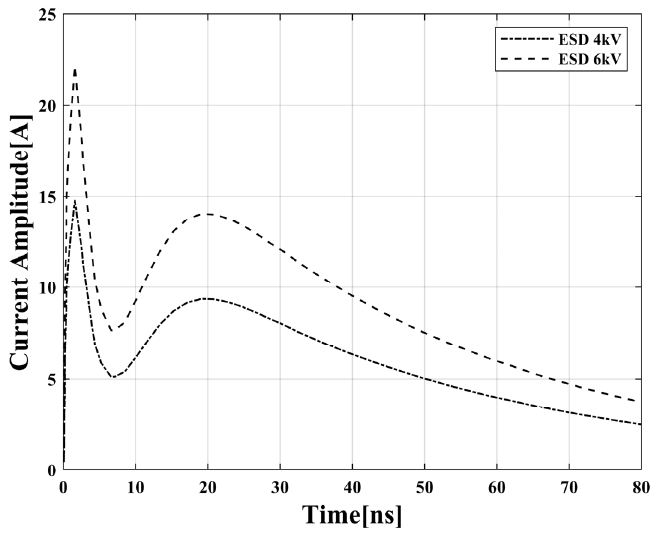
Figure 5. IEC 61000 ‐ 4 ‐ 2 4 kV and 6 kV ESD pulse current